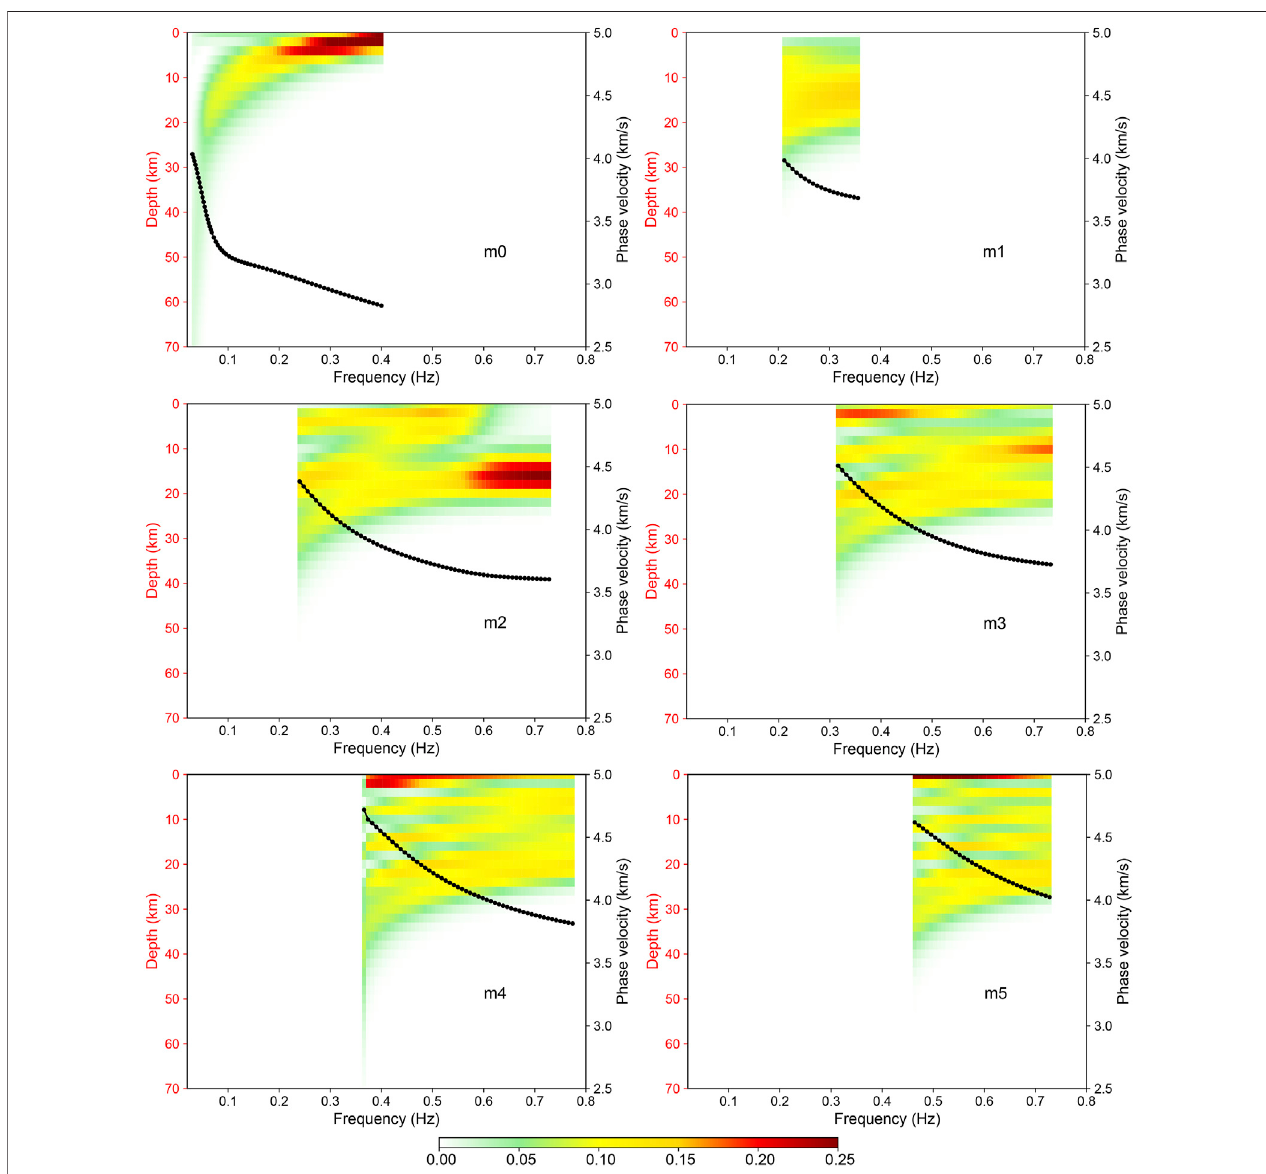
FIGURE 6 | Depth and frequency distributions of the sensitivity kernel function of the fi nal model of the multimodal dispersion curve inversion for array “ TH ” . The black dotted lines are the theoretical dispersion curves corresponding to the fi nal model (truncated according to the frequency range of the picked data points).